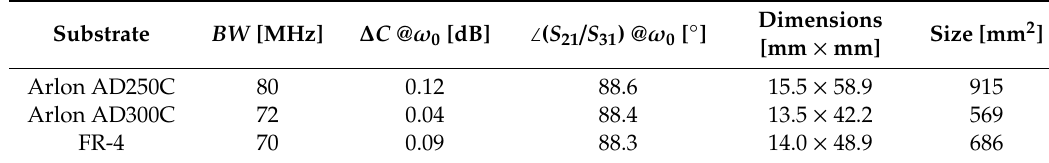
Table 5. Performance characteristics of the re-scaled B A (2,4) designs.